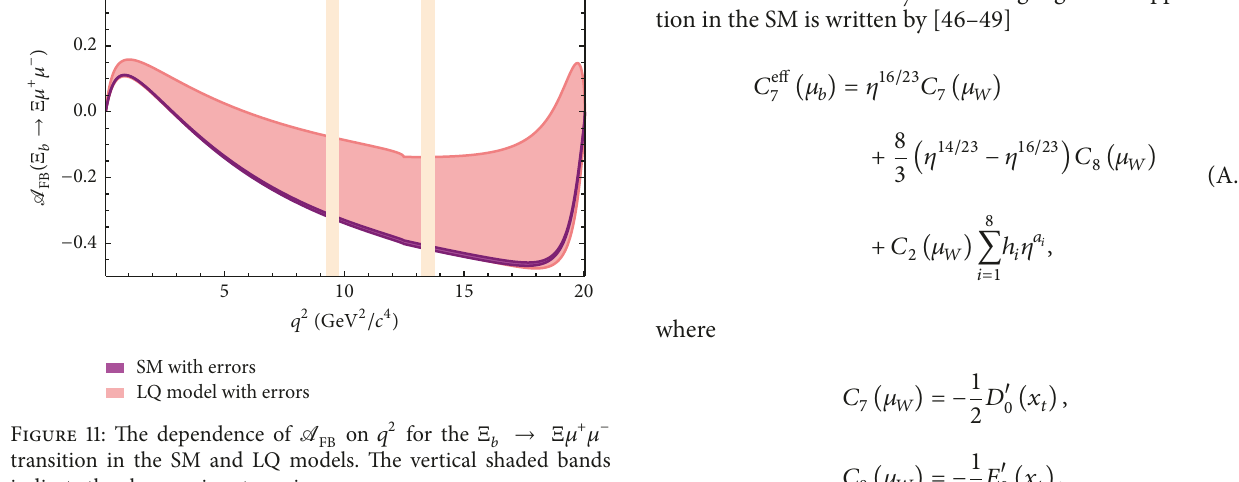
transition in the SM and LQ models. The vertical shaded bands indicate the charmonia veto regions.